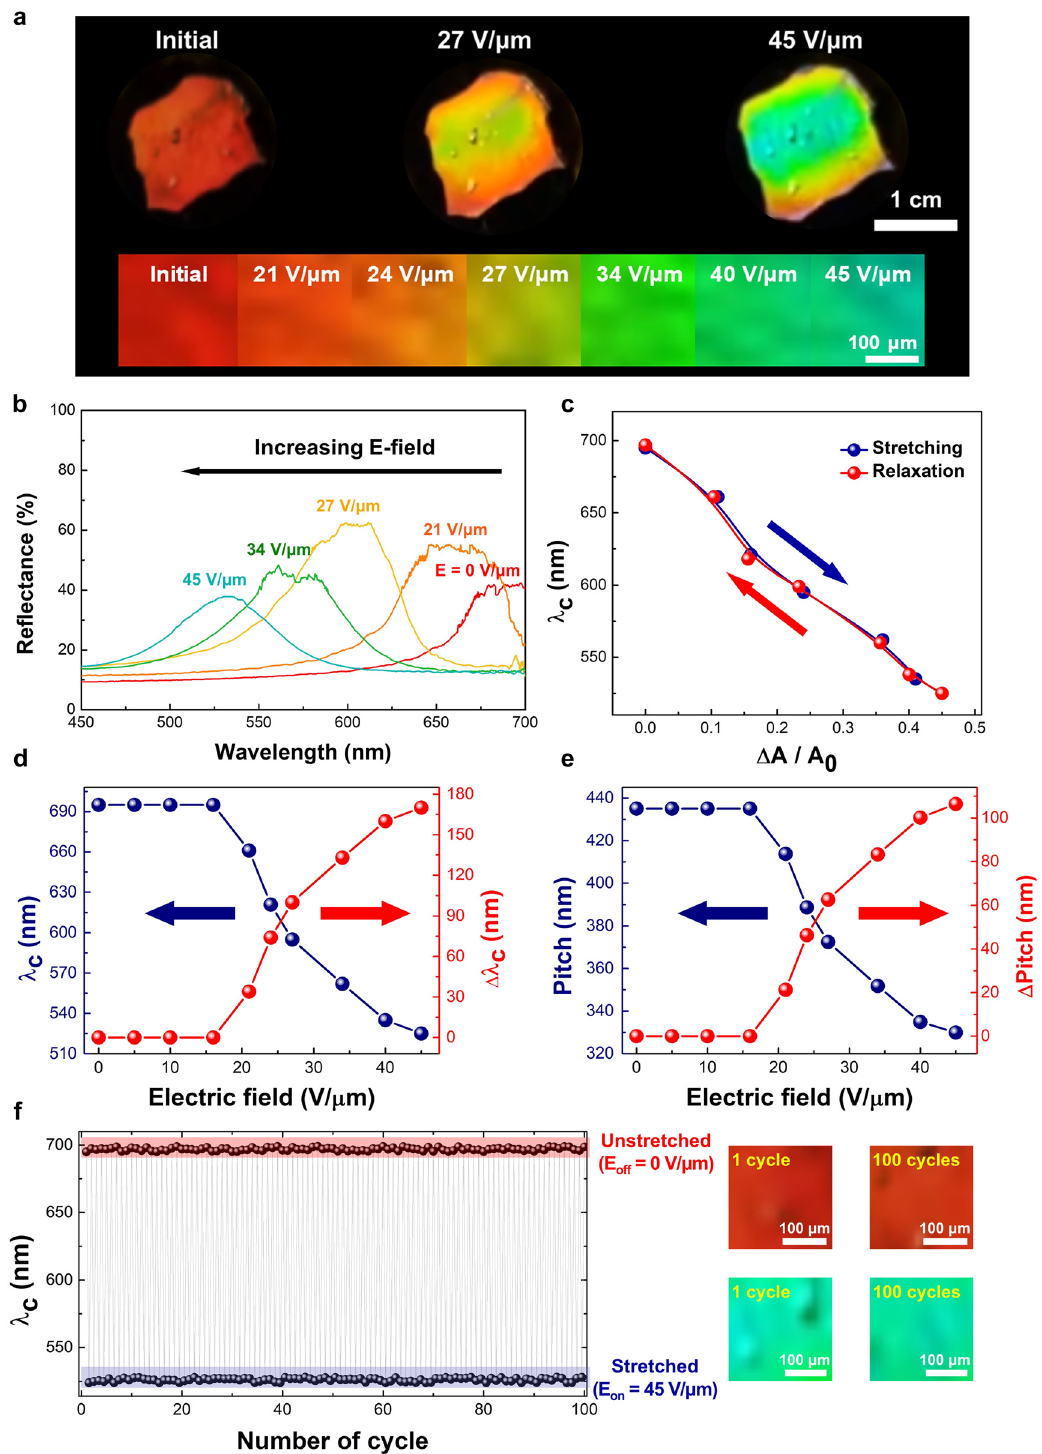
Figure 4: Electro-mechano-optical changes in the properties of chiral photonic gels: (a) reflective color change in electrically stretched chiral photonic gels as a function of the applied electric field; (b) photonic wavelength blue-shift of electrically stretched chiral photonic gels as a function of the applied electric field strength; (c) reversible central photonic wavelength ( λ c ) changes as a function of stretch power ( Δ A/A 0 , where ‘ Δ A ’ is the stretched scale of area, and ‘ A 0 ’ is the initial sample area of electrode); (d) reversible central photonic wavelength ( λ c ) positions and electrically controlled wavelength changes as a function of the applied electric fi eld strength; (e) calculated chiral pitch length andelectricallycontrolledpitchchangesasafunctionoftheappliedelectric fi eldstrength;(f)repeatableandrecoveredwavelengthcontrolof electricallystretchedchiralphotonicgelsupto100timesfromcontinuous,repeatingelectricalE-onandE-off-switchingofchiralphotonicgels with electrical stretching conditions of 45 V/ μ m. Notably, the electrical stimulus response of VHB in the combined soft actuator induced an indirect strain of chiral photonic gels. The frequency of the applied electric fi eld was 0.2 Hz sine